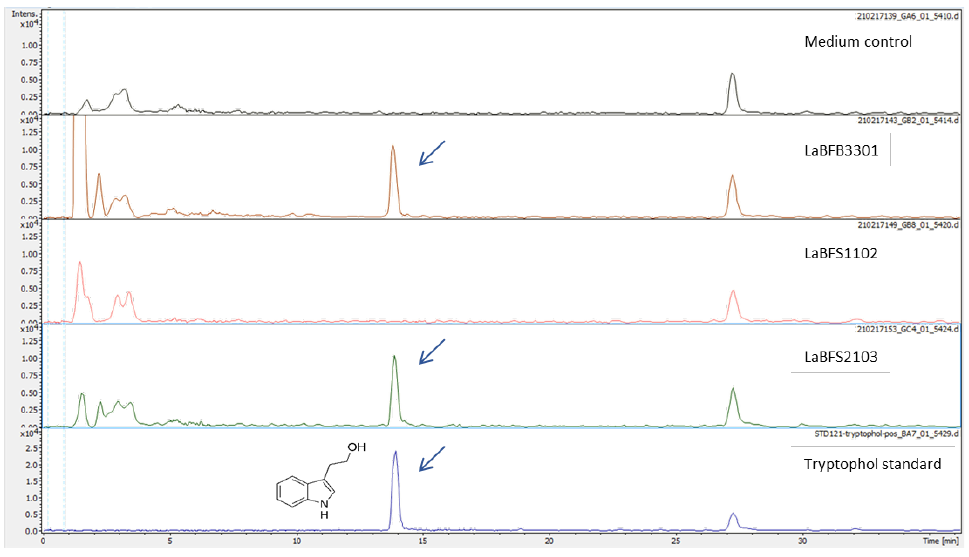
Figure 12. Ion chromatogram of m/z 162.0913 ± 0.02 for tryptophol found in the methanolic extracts of LaBFB3301 and LaBFS2103. of LaBFB3301 and